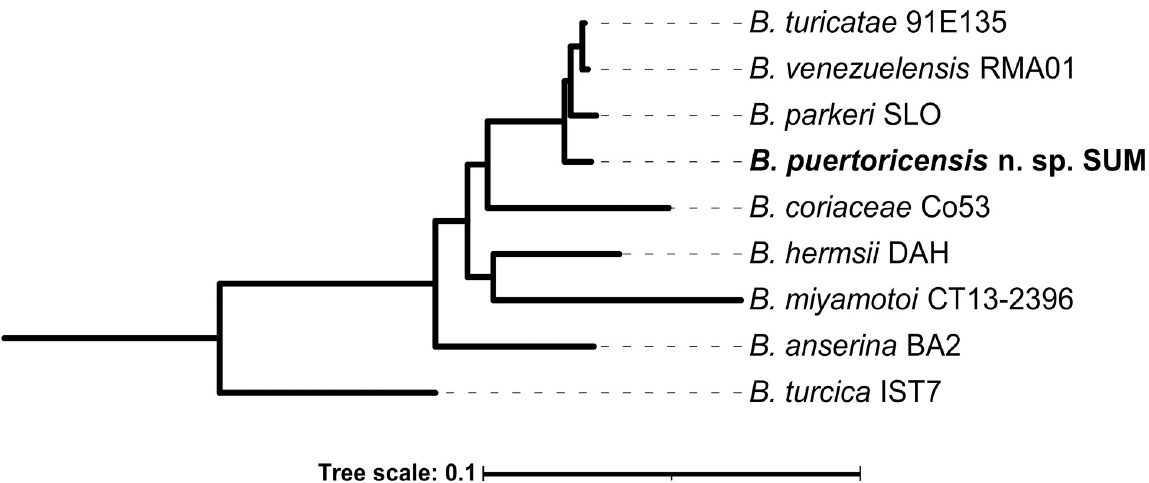
Fig 3. Genetic characterization of Borrelia puertoricensis sp. nov. To determine the placement of B . puertoricensis sp. nov. in relation to other relapsing fever species, a maximum-likelihood phylogenetic tree was inferred by IQ-TREE2 using an edge-linked proportional partition model of alignments of the rrs , glpQ , and flaB sequences. Branch supports are indicated as a percent of 1,000 ultrafast bootstraps. The scale bar shown reflects substitutions per site.